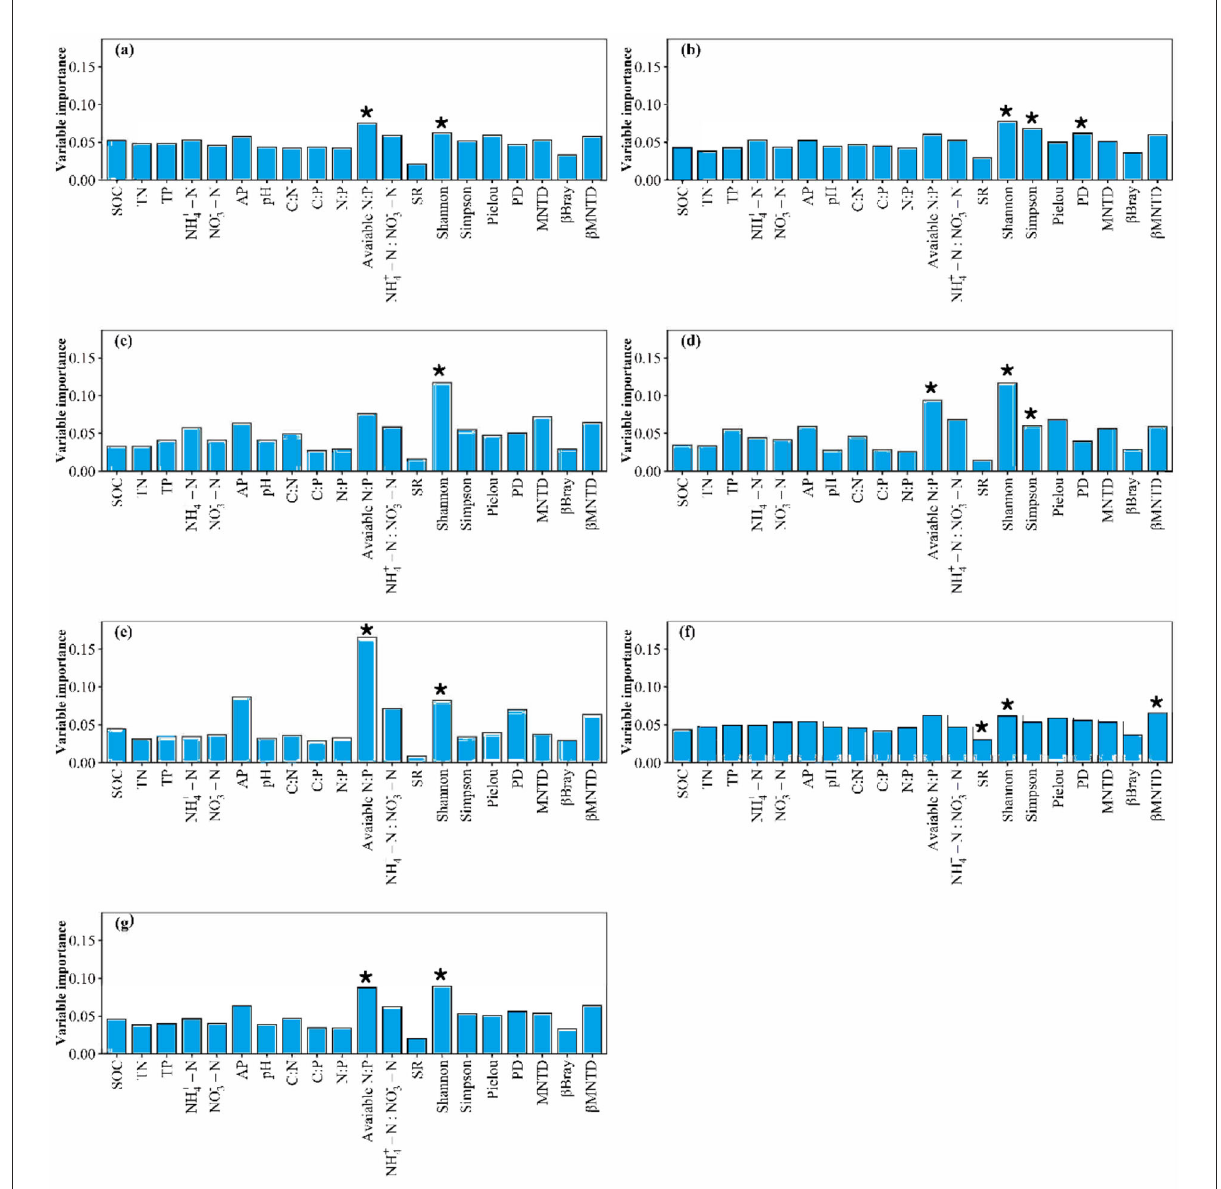
FIGURE8 The relative contributions of α - and β -diversity of forbs and soil variables for forbs (a) crude protein storage, (b) acid detergent fiber storage, (c) neutral detergent fiber storage, (d) ether extract storage, (e) crude ash storage, (f) water-soluble carbohydrates storage, and (g) nutrient storages, respectively. * indicates p <